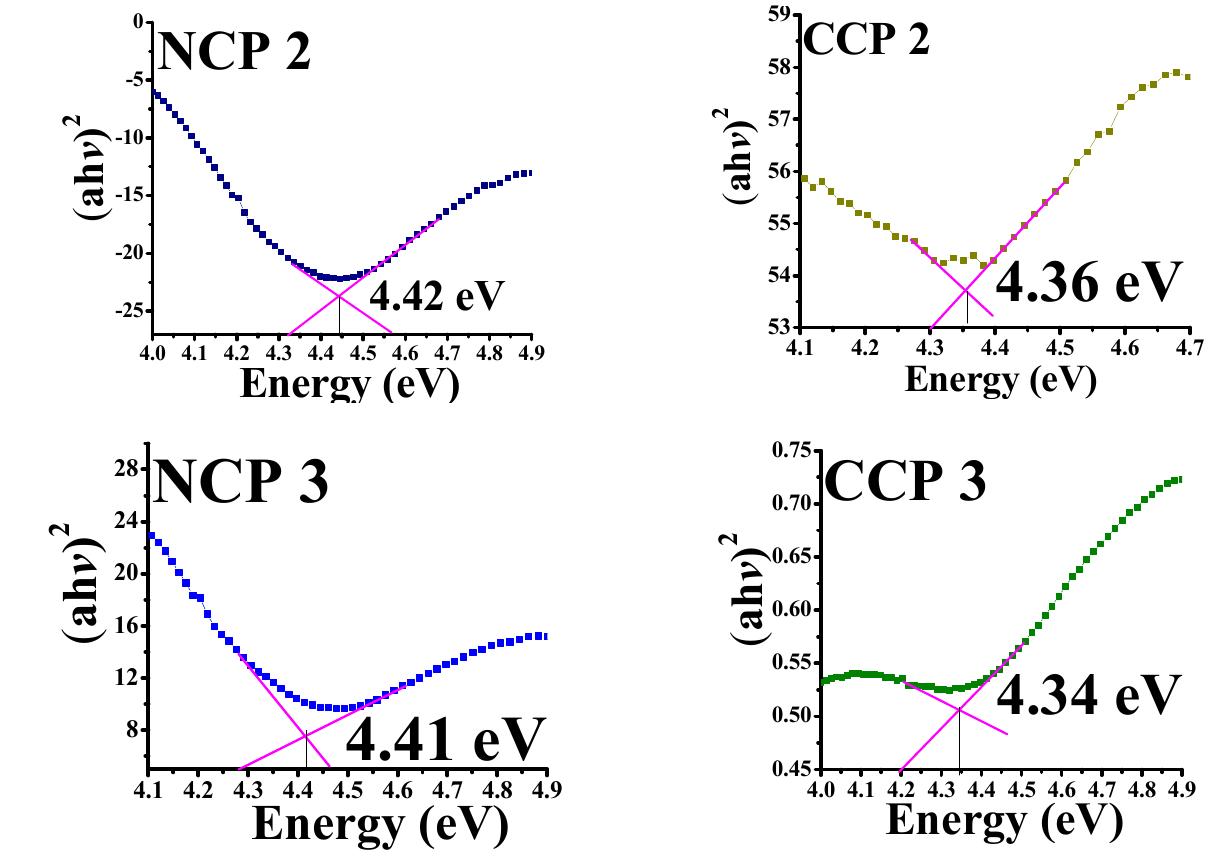
Figure 7. Tauc’s plots for bandgaps of all prepared samples.